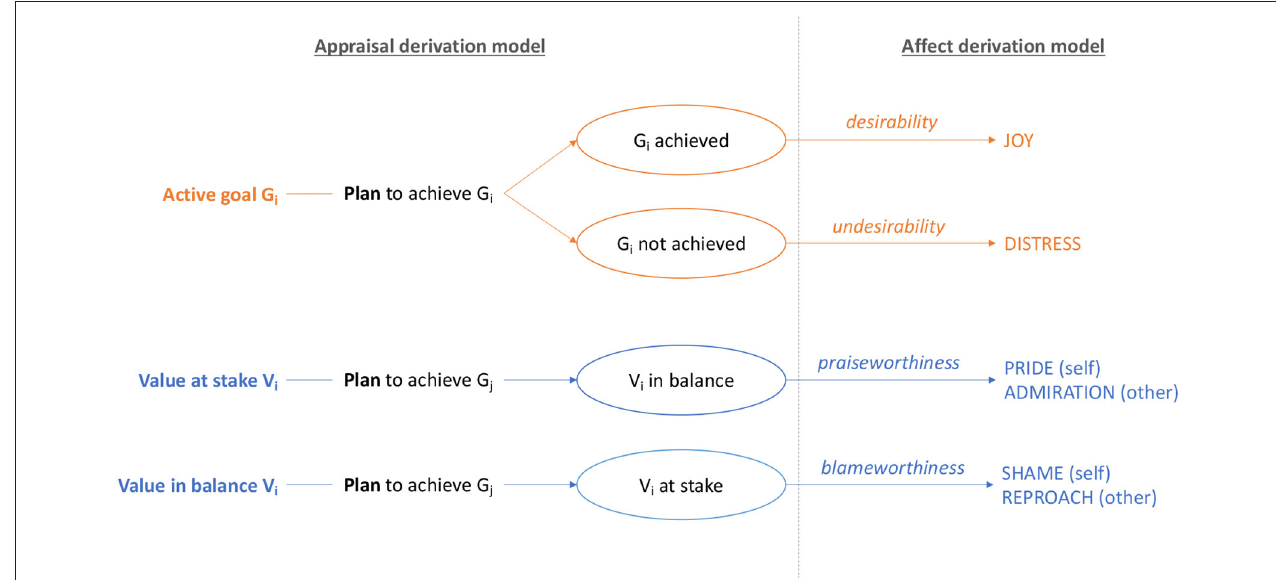
FIGURE 1 | Emotional appraisal and affect generation in the MEA model. Other appraisal variables (importance of goals, priority of values and plan length) do not determine the affect type, but only the intensity, and are not represented in the